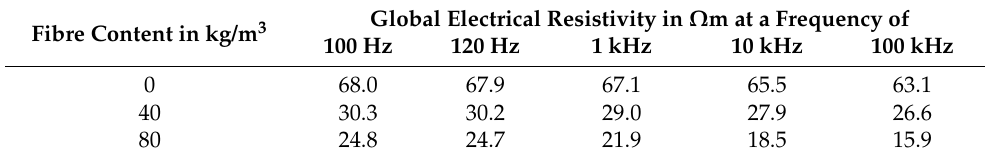
Table A46. Results of the resistivity measurements of the concrete mixture 32-60-300-00 after storage in Ca(OH) 2 for 185 days for the investigations of possible leaching effects.